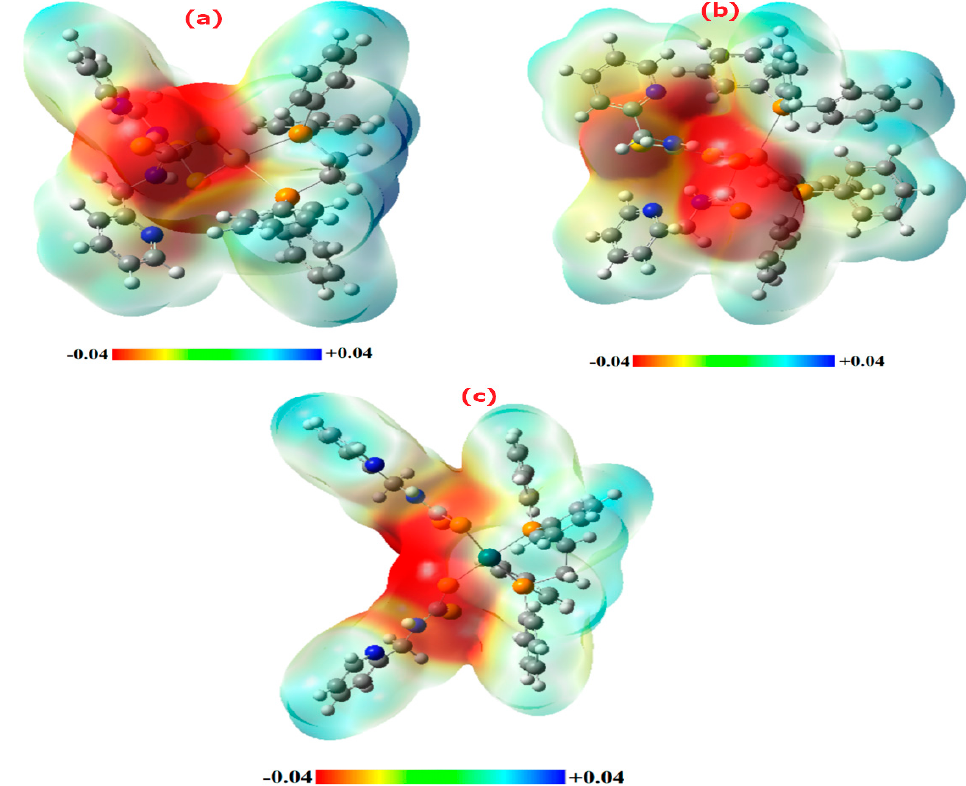
Figure 7. Molecular electrostatic potential calculated at the level of B3LYP/Def2-TZVP for ( a ) Cd(2) ( b ) Cd(2) , and ( c ) Pd(1) .